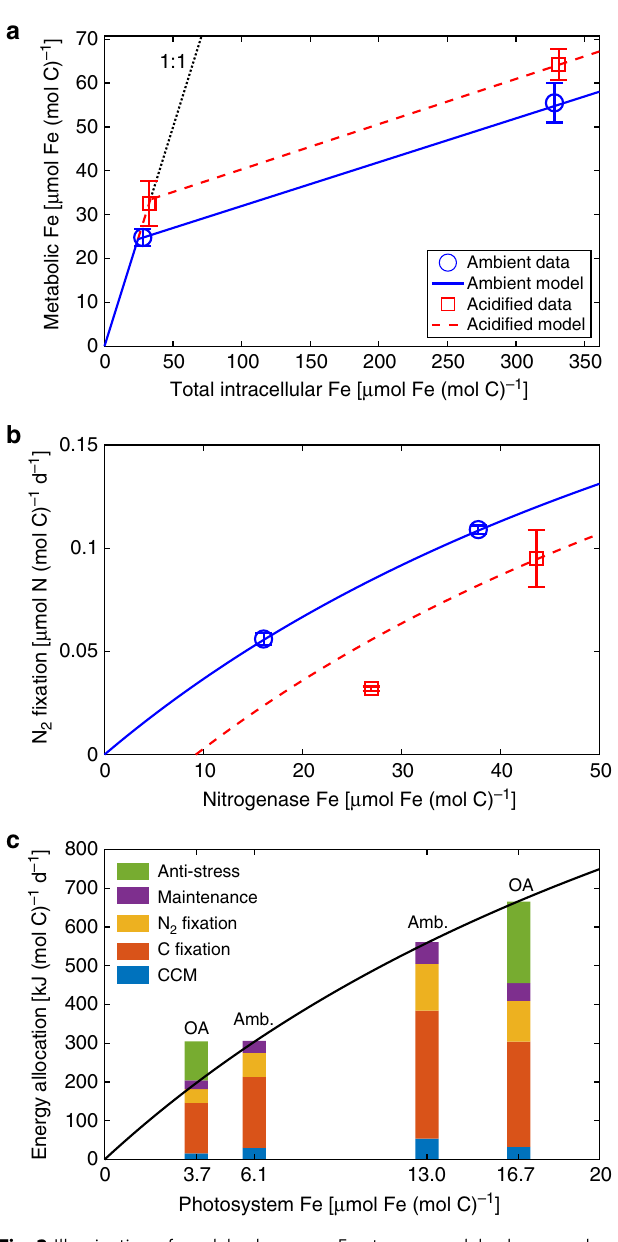
Fig. 2 Illumination of model schemes. a Fe storage model scheme and b nitrogenase Fe-determined N 2 fi xation rate model scheme compared with the experimental data under ambient (blue) and acidi fi ed (red) conditions. c Energy production model scheme (black line) and the estimates (colored bars) of energy allocation to different cellular processes in the culture experiments under ambient (Amb.) and acidi fi ed (OA) conditions. For experimental data, error bars represent the s.d. of biological replicates ( n =